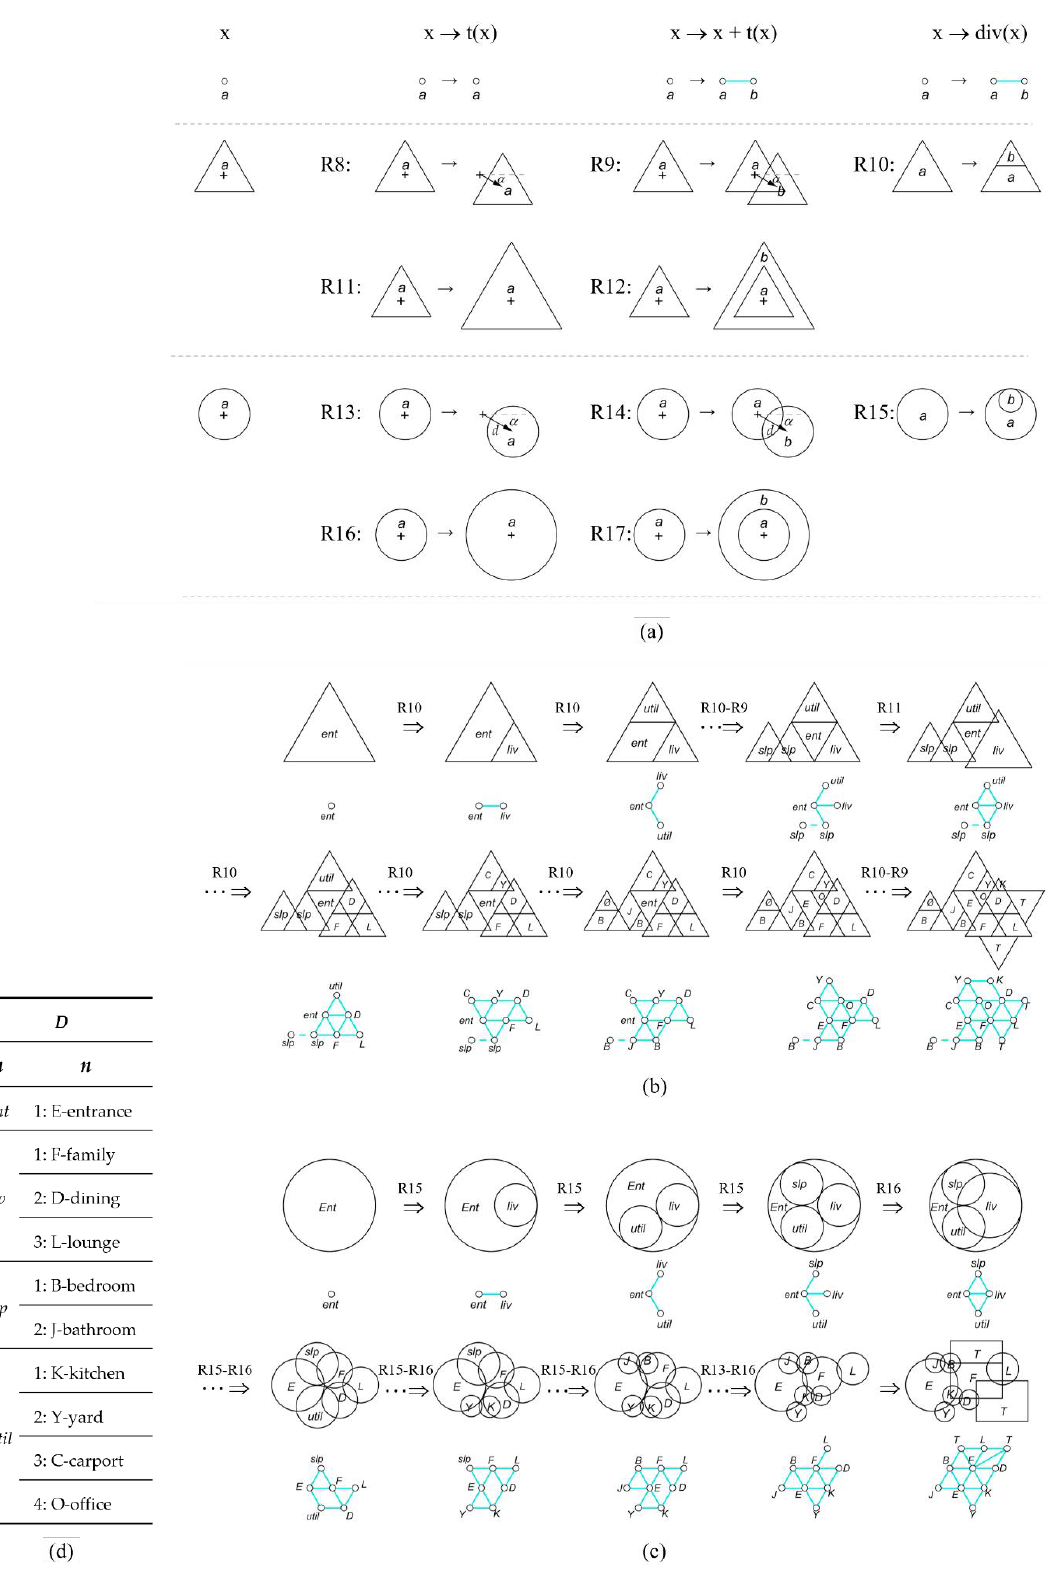
Figure 4. Rule schema, adjacency graph rules, and shape rules ( a ), with their rule iteration on regenerating plans of the Vigo Sundt house ( b ) and the Ralph Jester house ( c ). Labels a and b are replaced by names outlined in the list of descriptions D mn ( d ).